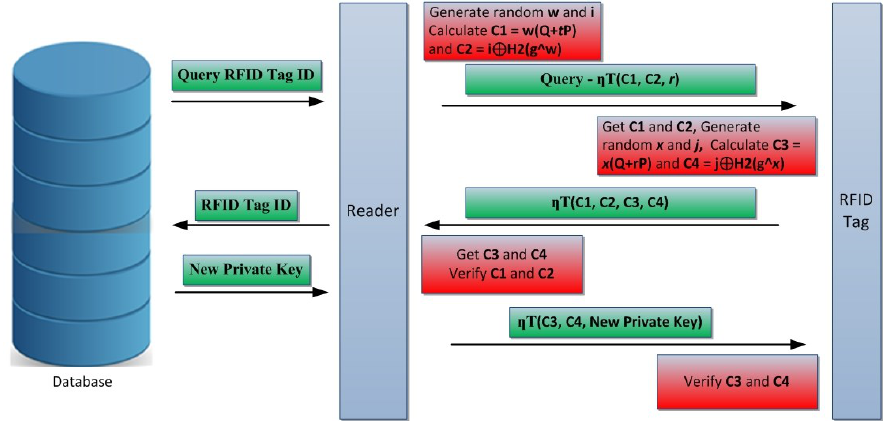
Fig. 1. Three-way handshake of the key management